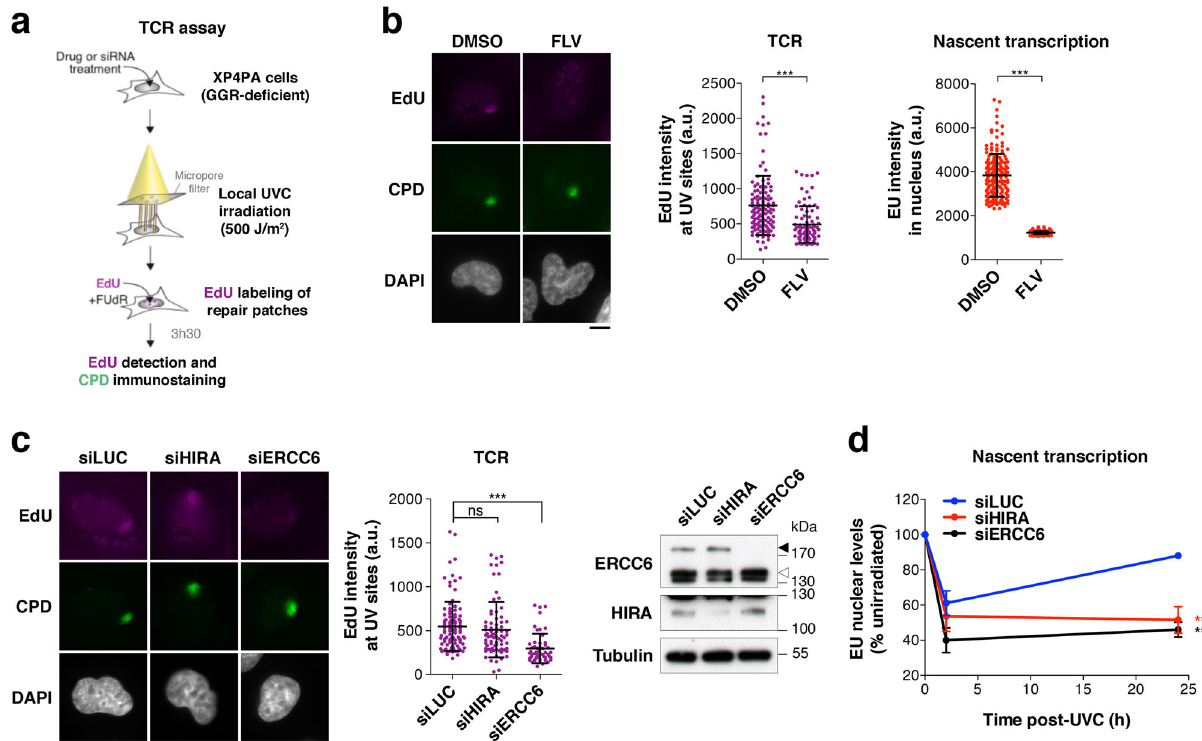
Fig. 2 HIRA does not contribute to Transcription-Coupled Repair. a Schematic representation of the Transcription-Coupled Repair (TCR) assay performed in GGR-de fi cient fi broblasts (XPC-null). b – c TCR assay in cells treated with ( b ) the transcription inhibitor fl avopiridol (FLV; DMSO, vehicle) or ( c ) the indicated siRNAs (siLUC, control). EdU marks repair synthesis. Knockdown ef fi ciencies are controlled by western blot (black arrowhead, full-length ERCC6; white arrowhead, ERCC6 splice variant; Tubulin, loading control). Transcriptional activity in each condition is monitored by EU staining of nascent transcripts. The scatter plots show mean values ± s.d. from at least 53 UV damage sites scored in a representative experiment out of three. a.u. arbitrary units. Scale bars, 10 μ m. d Nascent transcript levels analysed by EU incorporation in UVC-irradiated GGR-de fi cient fi broblasts treated with the indicated siRNAs (siLUC, control). The line graph shows mean values ± s.d. from two independent experiments (at least 50 cells were scored in each condition). Statistical signi fi cance is calculated by two-sided Student ’ s t -test ( b ), one-way ( c ) and two-way ANOVA ( d ) with Bonferroni posttest. **: p < 0.01; ***: p < 0.001; ns: p > 0.05. Source data are provided as a Source Data fi